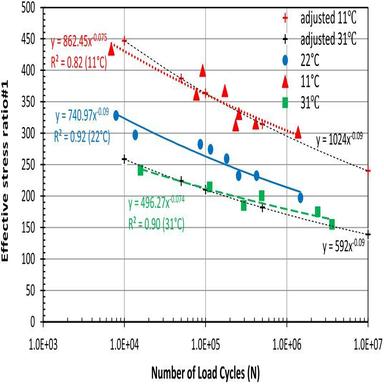
FBS fatigue relationships at different temperatures - power curve adjustments.